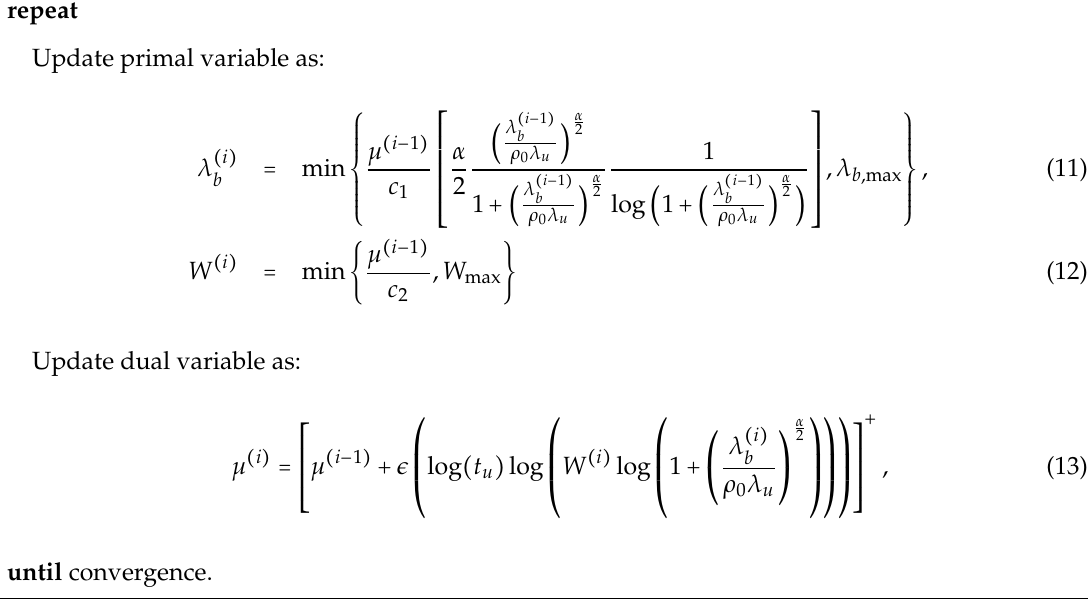
Algorithm 1 Jointly optimal frequency bandwidth and network density